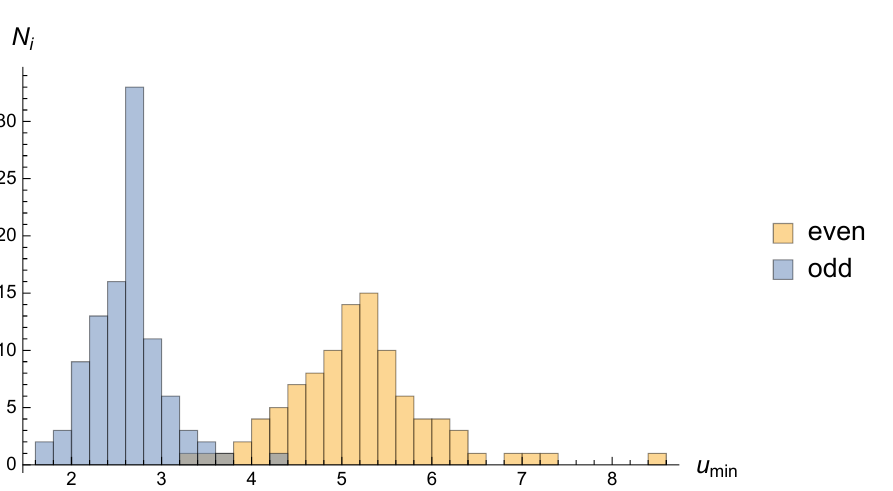
Figure 4. Histogram of u odd